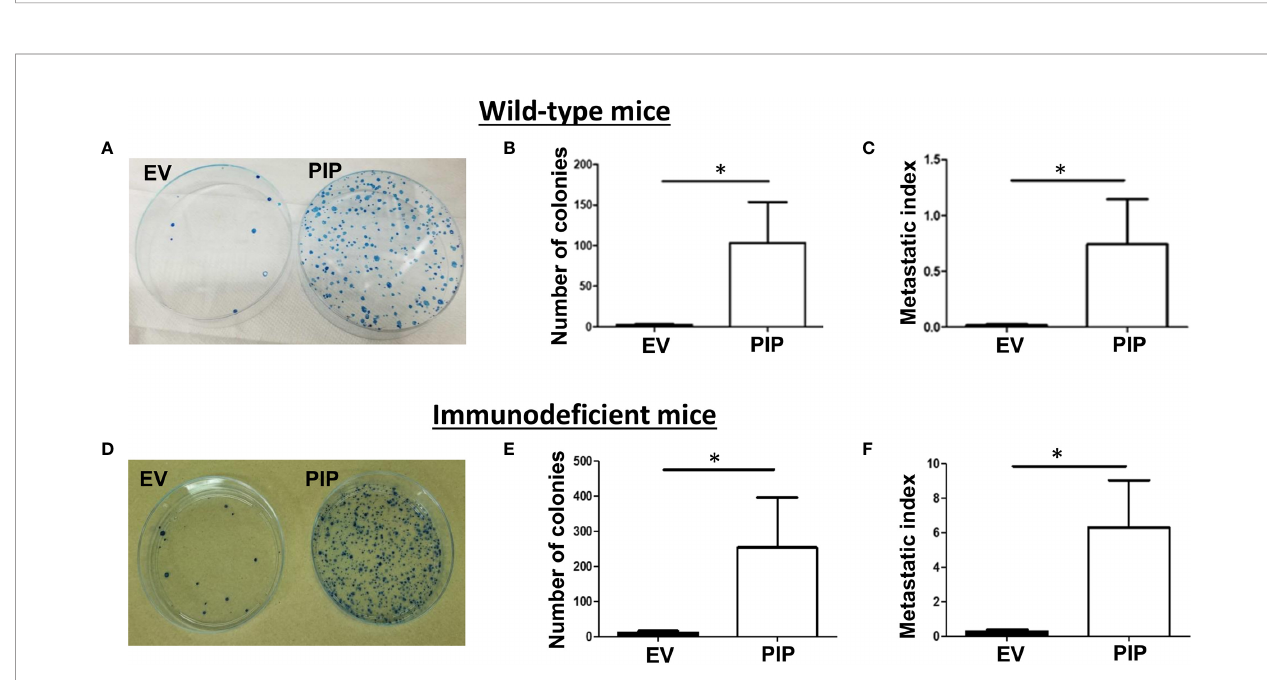
FIGURE 6 | PIP expression by 4T1 cells is associated with increased lung metastasis. Wild-type (WT) and Rag2 − / − g c − / − double knockout (DKO) female BALB/c mice were injected with PIP expressing (PIP) or empty vector control (EV) 4T1 cells and after 14 days, mice were sacri fi ced, and lung metastasis was assessed by the clonogenic metastasis assay. Panels show representative images of the 4T1 colonies (A, D) , the number of metastatic 4T1 colonies (B, E) and the metastatic index (C, F) , respectively, for WT (A – C) and DKO (D – F) mice. Results representative of two to three experiments and are expressed as mean ± SEM. n = 3 – 5 mice per group. *p < 0.05; Mann – Whitney test was